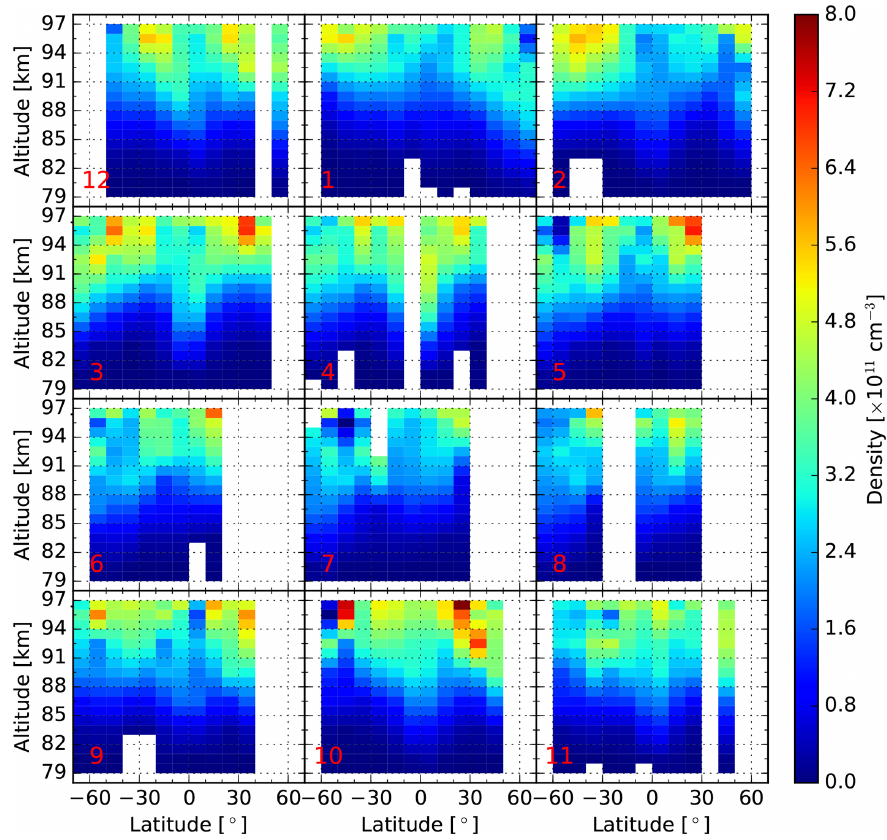
Figure 8. Latitude–altitude distribution of the zonal mean atomic oxygen density for 2007. Each row represents approximately a season. The data are linearly interpolated into a 1km altitude grid for better illustration. The numbers in the subplots indicate the month of the